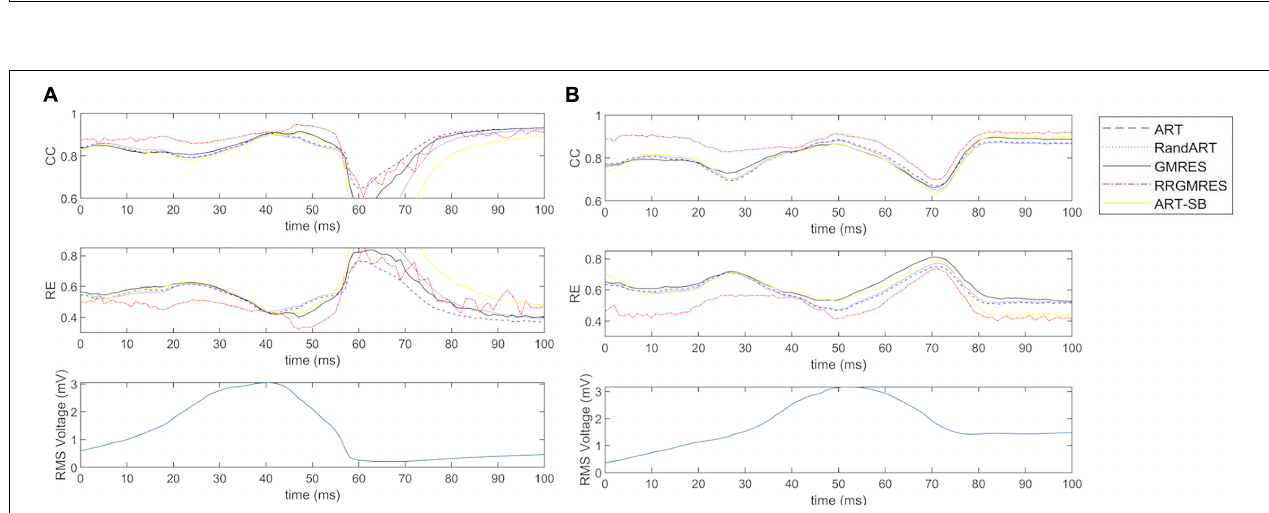
FIGURE 7 | RE and CC of each reconstruction technique and RMS of the target potentials, averaged over space during a defined temporal window over the QRS, for (A) a control Utah dataset (Control 1) and (B) an ischemia Utah dataset (I3).